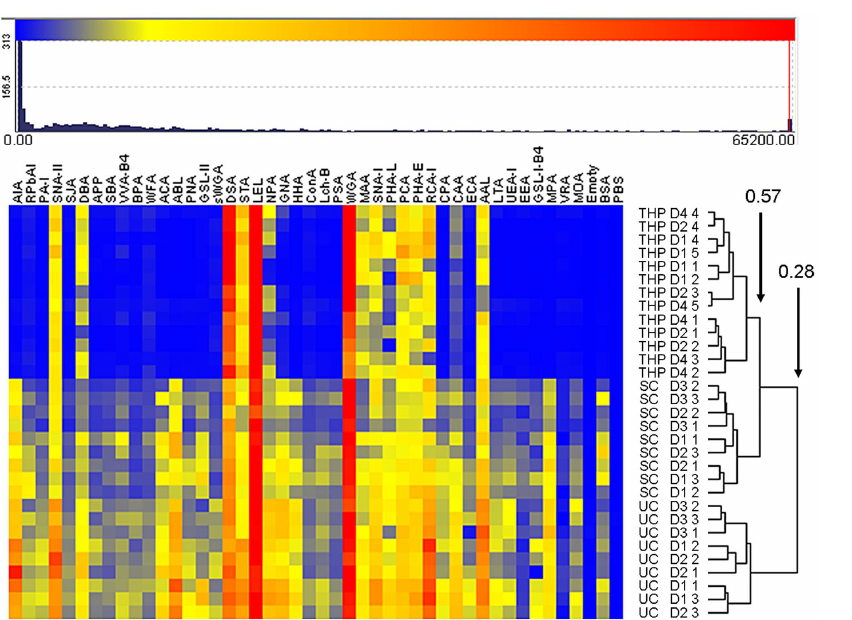
Figure 5. Unsupervised hierarchical clustering of lectin microarray profiles for intact urine uEVs and purified THP from three healthy individuals. LM data for all uEV (donors D1, D2, and D3) and THP samples (donors D1, D2 and D4) normalized by rescaling (range 0 to 65200). Individual technical replicates are indicated by designation of 1 to 5. Two groups are evident at 0.28 similarity, three groups at 0.57 similarity. Clustering based on Euclidean distance, complete linkage method. Responses and clustering shown are typical of those obtained from a minimum of 10 healthy uEV enrichment and profiling experiments.